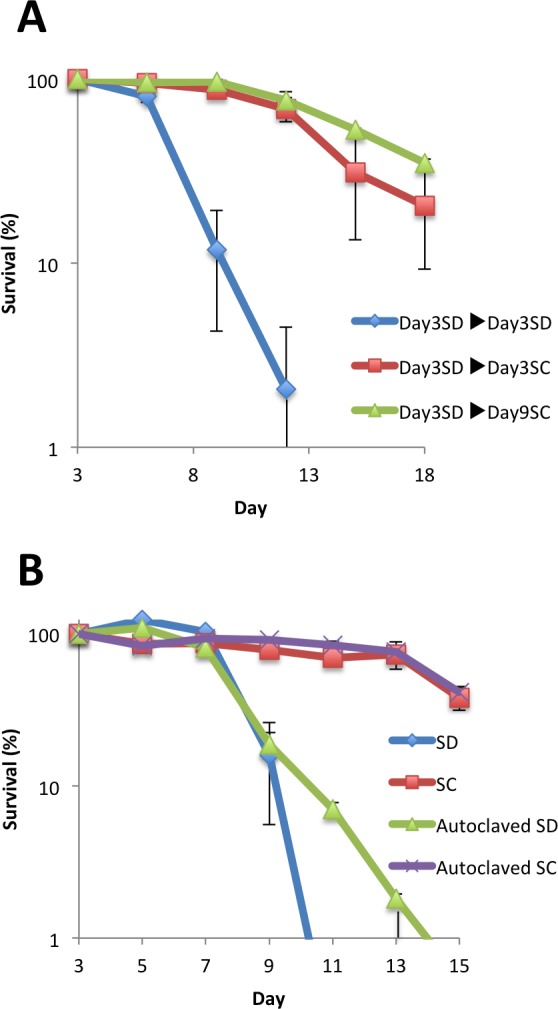
Used SC media contained a heat-resistant factor for chronological longevity.(A) Effect of media swap using older cultures. The original media of the cells grown in SD as in Fig 1 were swapped to the medium recovered from the culture in SD for 3 days, SC for 3 days, or SC for 9 days. (B) Autoclaving did not affect the longevity activity in used SC medium. Culture media of YOM36 cells at day 3 were recovered, and the supernatants were autoclaved at 121°C for 15 min. The autoclaved medium was recombined with the original, centrifuged cell pellet and then CFUs of the culture were examined at the indicated times. Error bars represent the means ± SD (n = 3). (A) P<0.01 (Day 3 SD→Day 3 SD vs Day 3 SD→Day 3 SC; Day 3 SD→Day 3 SD vs Day 3 SD→Day 9 SC).